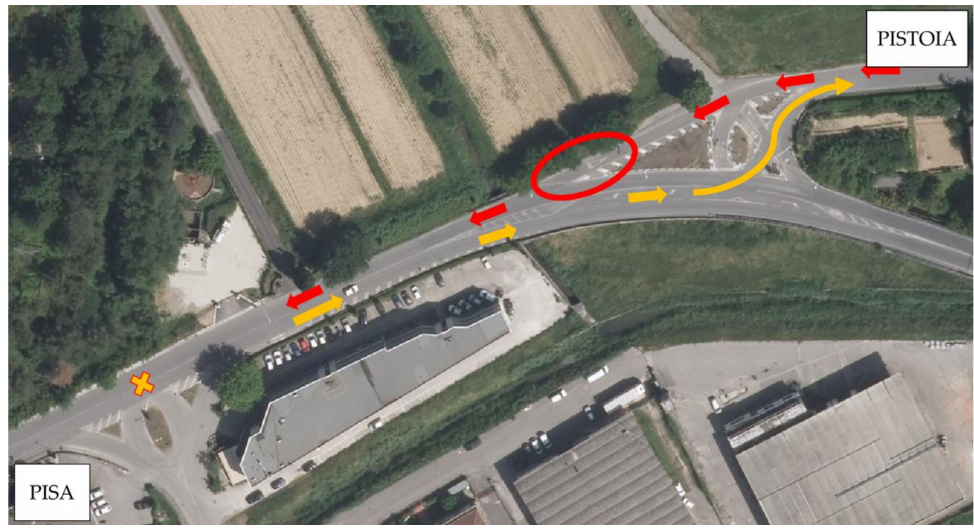
Figure 16. Focus on the paths followed by the laser profiler in test site